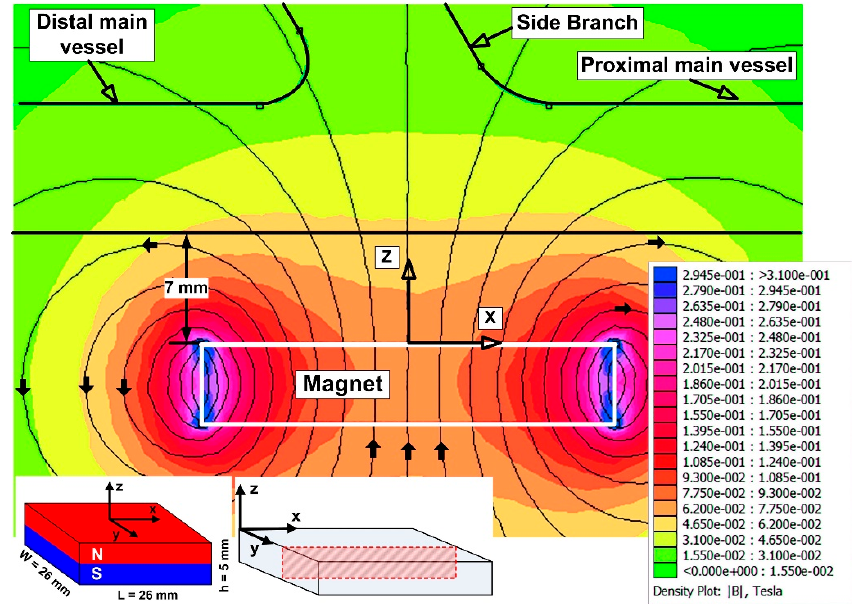
Figure 10. Numerical simulation of the magnetic field used during the experimental investigation (via the free Finite Element Methods Magnetics (FEMM) software). This figure shows the magnitude of the magnetic field produced by the Y8T permanent magnet in the longitudinal section, along with the bottom wall of the bypass graft at a distance of 7 mm from the magnet’s surface.